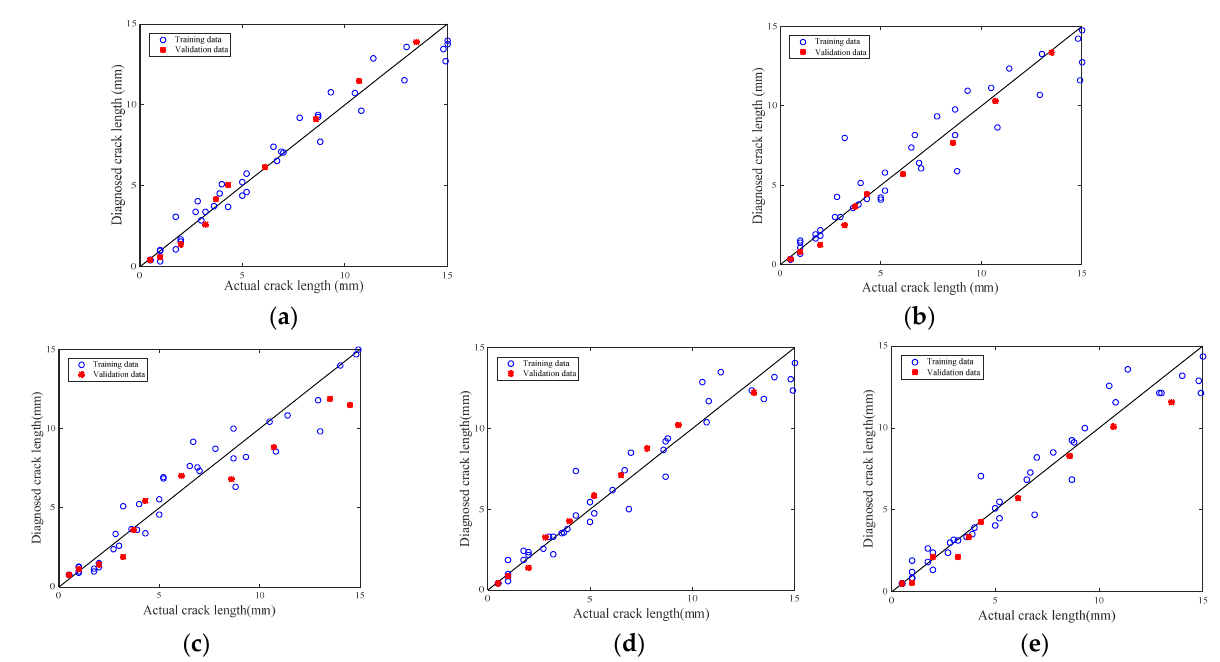
Figure 20. Diagnosed crack lengths with ( a ) 300–700 kHz L-Chip excitation signal; ( b ) 500 kHz GCC excitation signal; ( c ) 3.5 cycle 160 kHz Hanning-windowed tone burst signal; ( d ) 0–300 kHz L-Chirp excitation signal; and ( e ) 150 kHz GCC excitation signal.